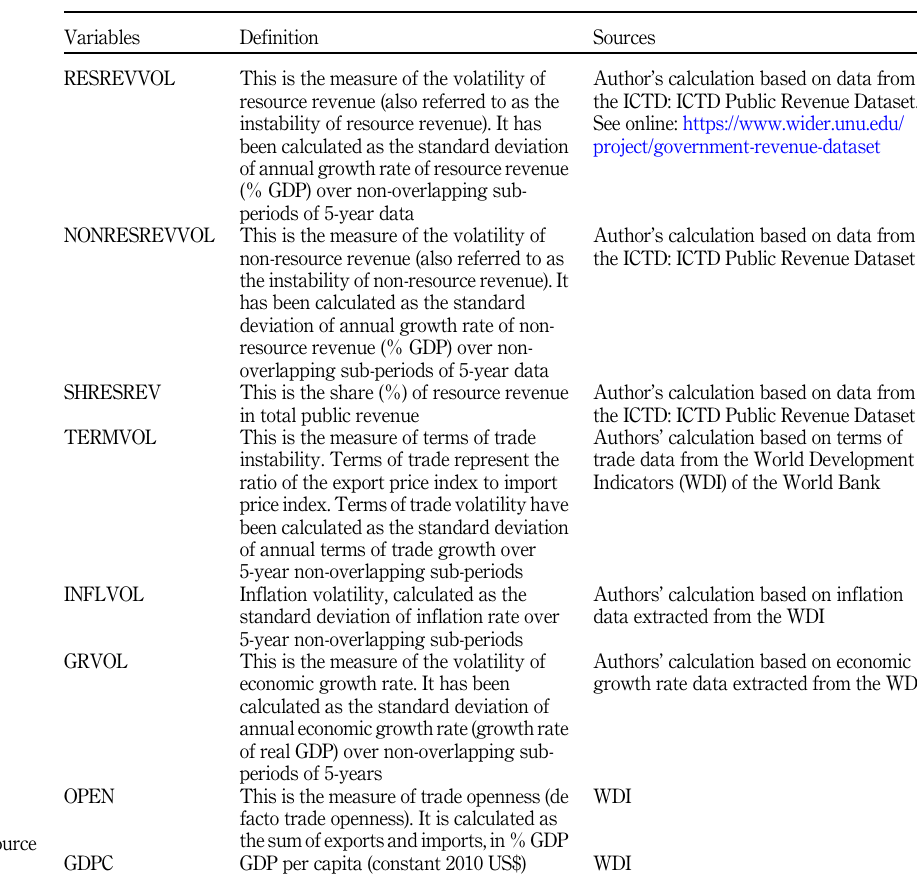
Table A1. Definition and source of